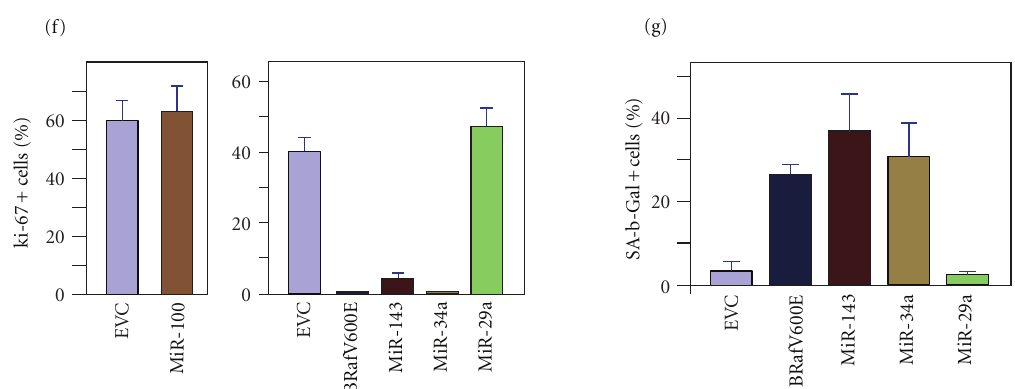
Figure 3: Melanocytes were infected with EVC or with vector expressing the indicated miRNA. (a) Quantification of miRNAs expression by qRT-PCR in indicated miRNA expressing cells. (b)–(e) The expression levels of the indicated senescence markers in the indicated miRNA expressing cells were quantified by qRT-PCR and normalized to the level of b-actin. The values represent the means and standard deviation from three independent experiments. Cells infected with the indicated miRNA expressing virus were also isolated after selection, fixed, and stained for (f) ki-67 or (g) SA- β -Gal